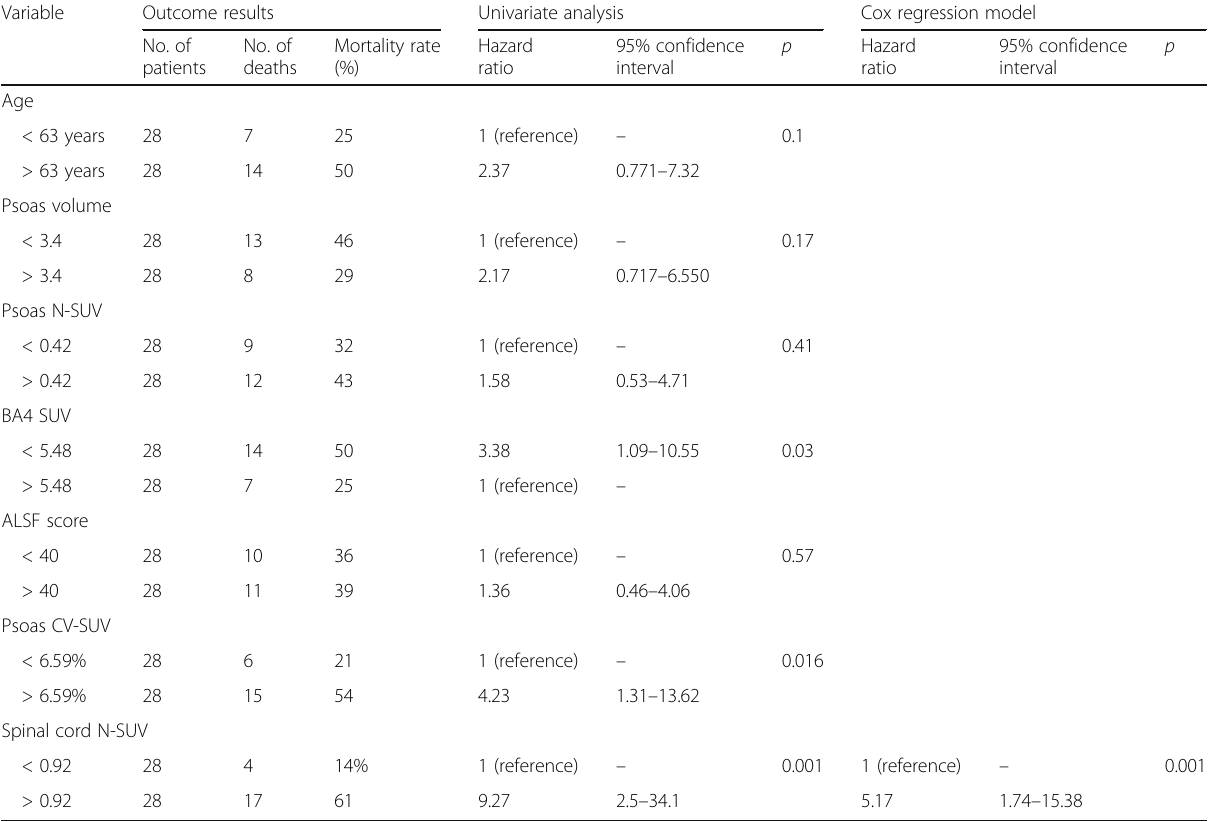
Table 2 Predictive power of tested variables at univariate and multivariate analysis